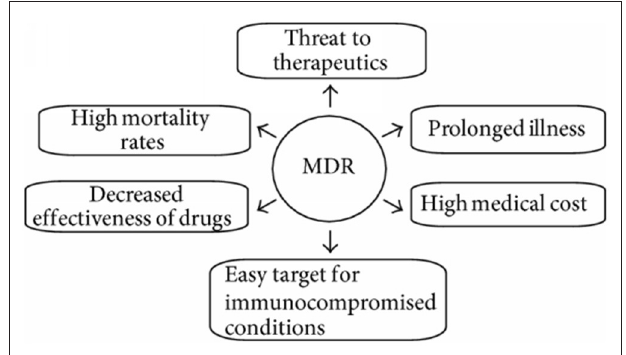
FIGURE 1 | Various social- and health-related issues with multidrug-resistant bacteria (Tanwar et al., 2014).